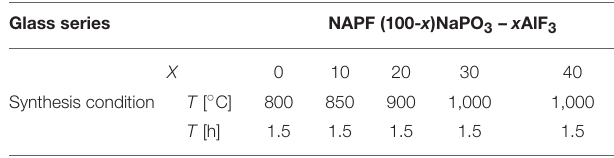
TABLE 1 | Nominal compositions (mol %) and synthesis conditions for NAPF glass series. Glass